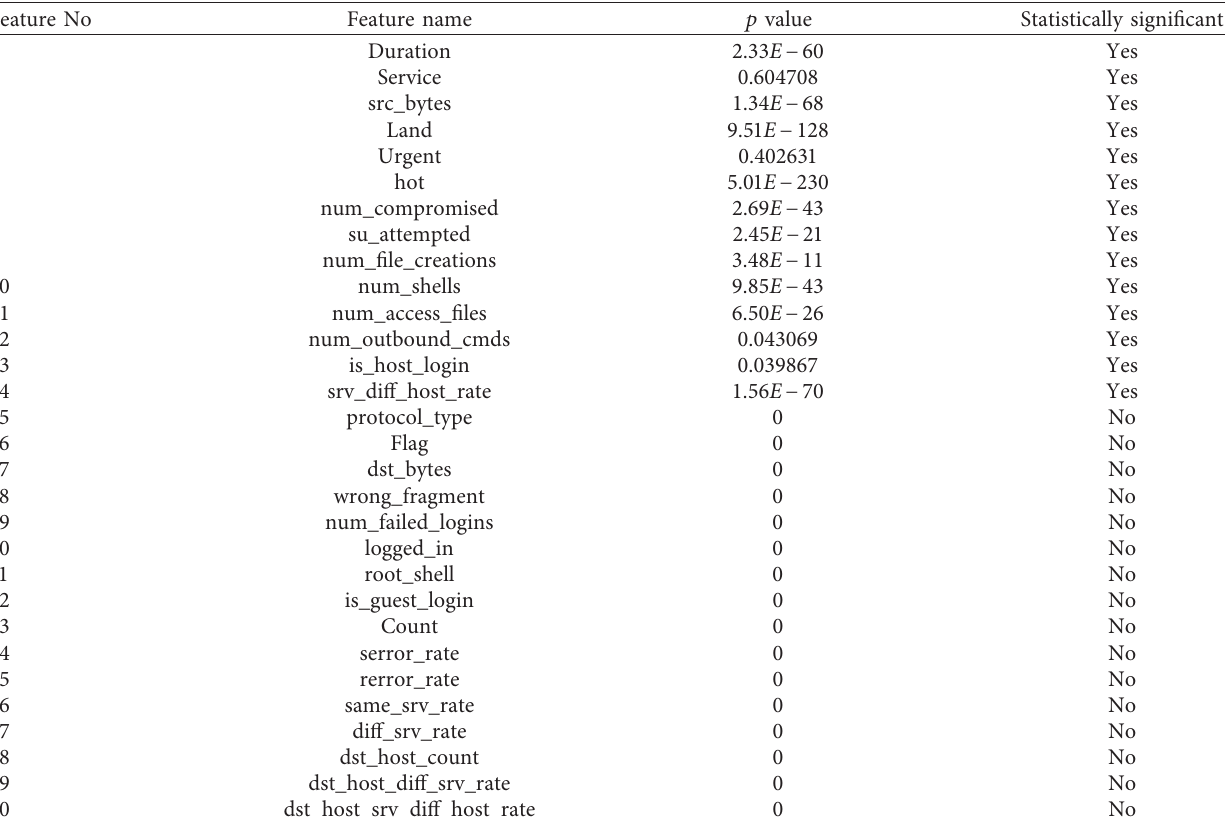
Table 8: Feature selection of KDD dataset using p values.